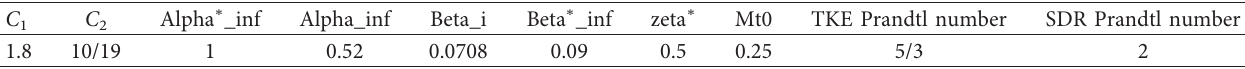
Table 1: Coefficients for